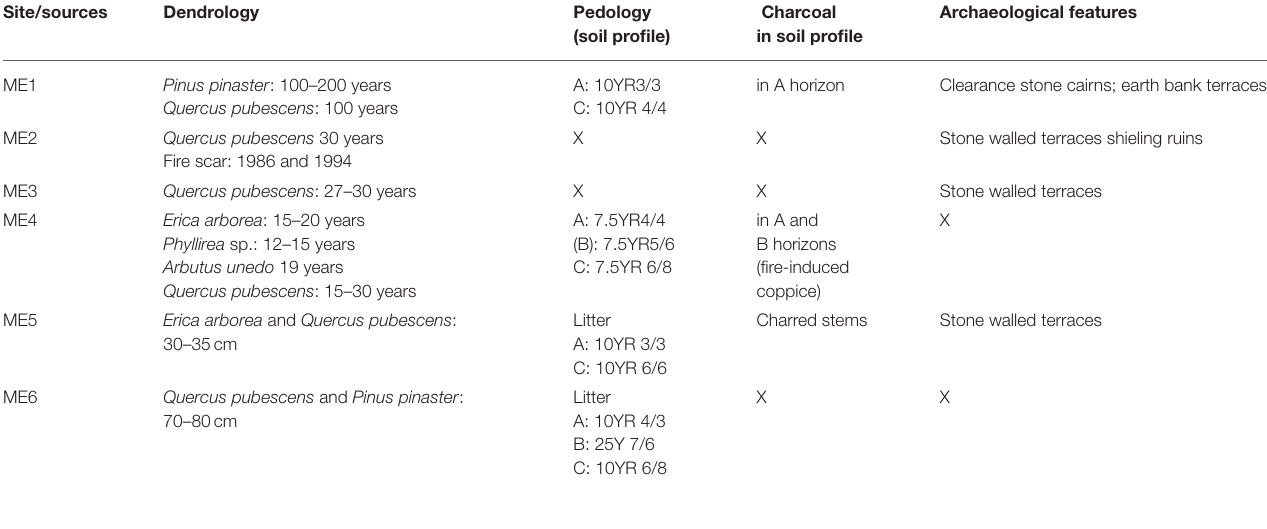
TABLE 5 | Merula Valley (cf. Figure 4 ). Archaeological features from field survey, soil profile, and current vegetation (winter, 2017).